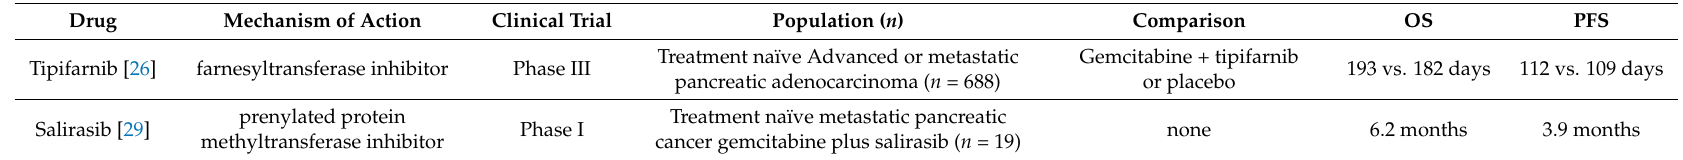
Table 1. Select trials targeting RAS.